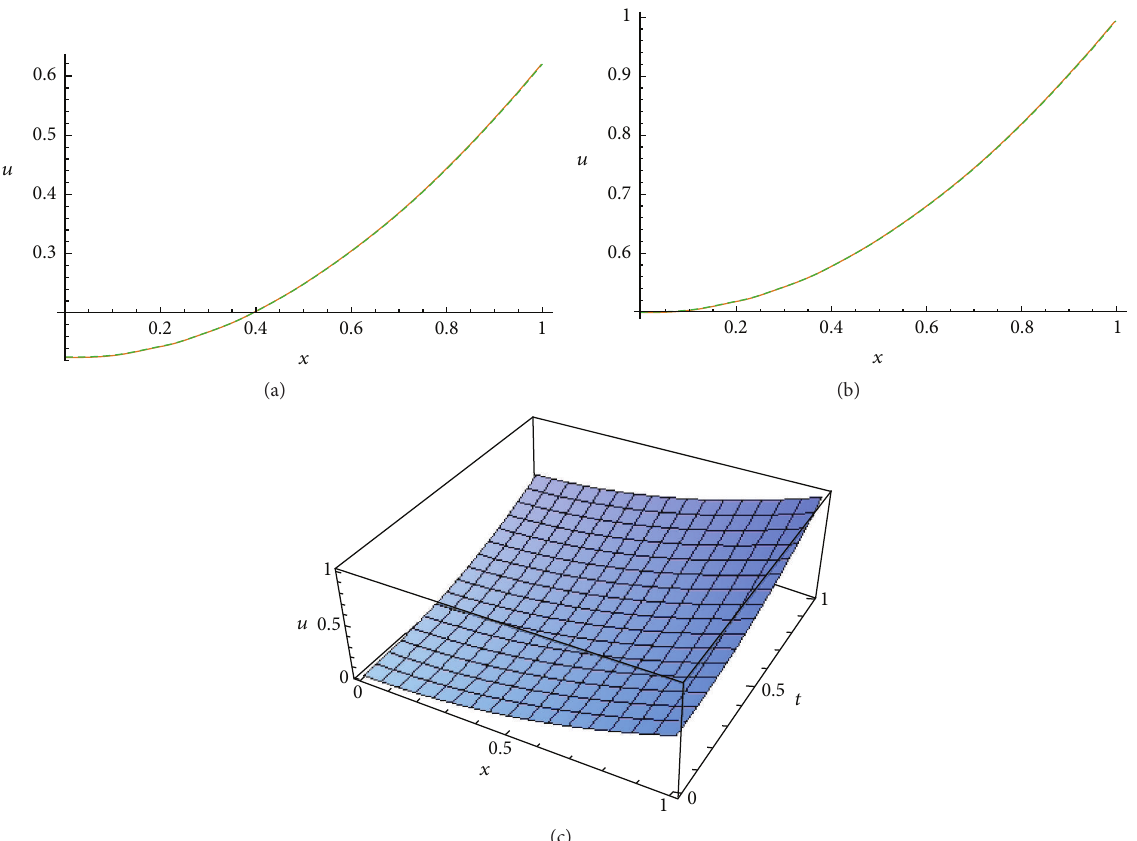
Figure 4: (a) Plots of the approximate solution for different values of 𝛼 and the exact solution, in case 𝑡 = 1/2 ; for (45). (b) Plots of the approximate solution for different values of 𝛼 and the exact solution, in case 𝑡 = 1 ; for (45). (c) Plots of the approximate solution, in case 𝛼 = 2 for